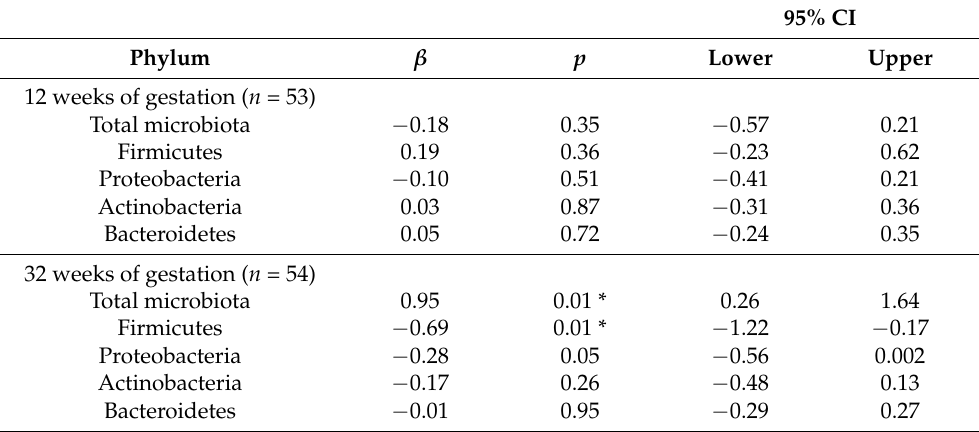
Table 4. Associations between the SDIs of total microbiota and four phyla in maternal feces and CB CCL17 levels 1 .